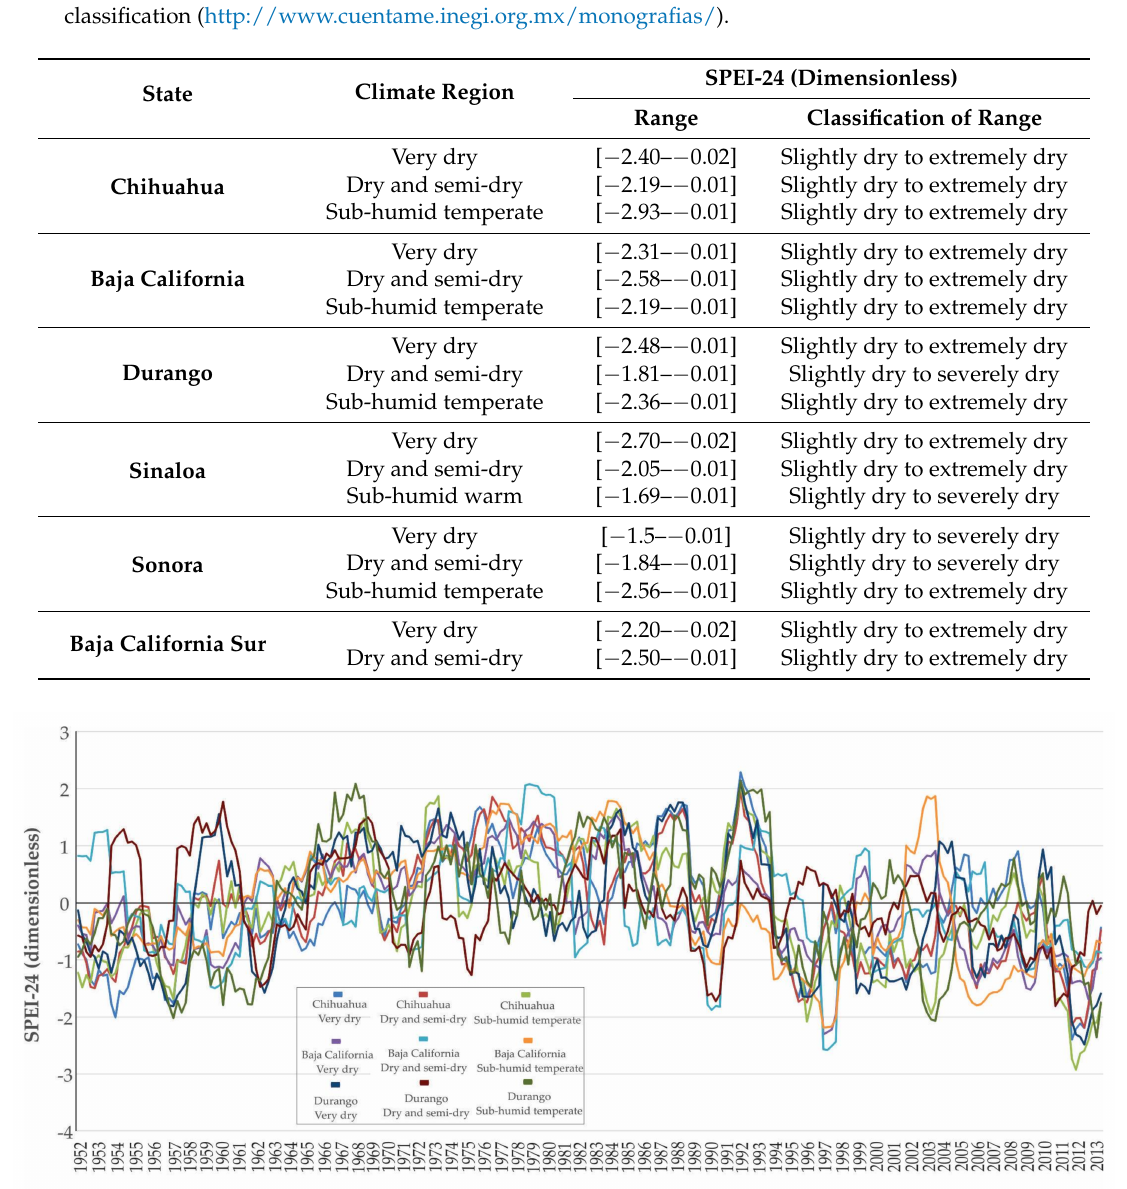
Figure 4. Seasonal variation of SPEI-24 by climate region in states in northern Mexico (Chihuahua, Baja California and Durango) in the period 1952–2013 (dimensionless). Source: Authors,